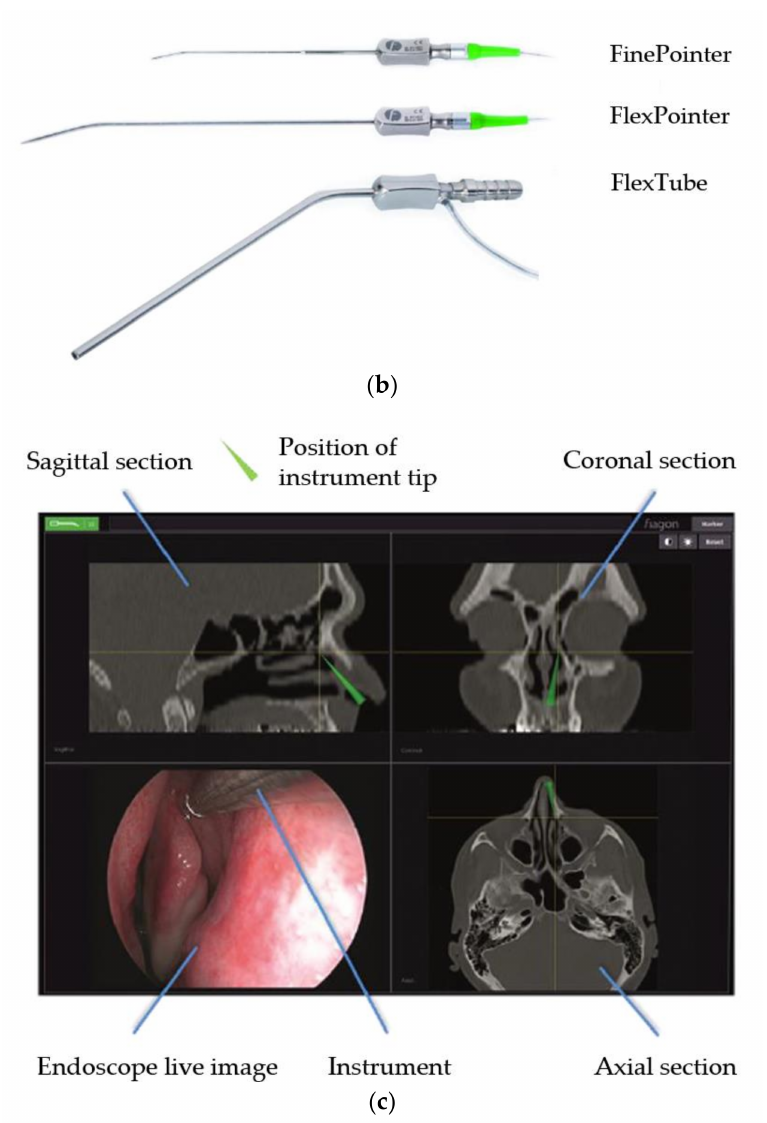
Figure 1. ( a ) Fiagon navigation system. ( b ) Fiagon navigation instruments for sinus surgery. ( c ) Output screen view with endoscopy image as well as sagittal, coronal, and axial CT sectional views